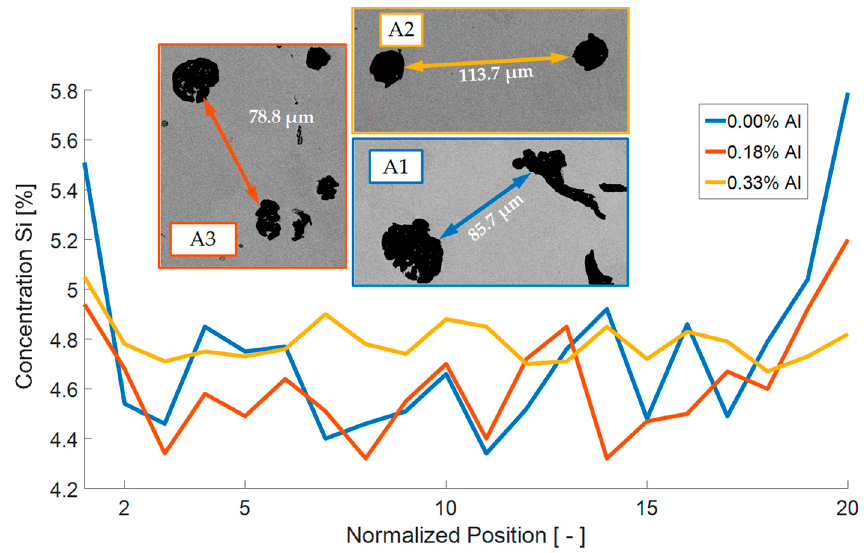
Figure 3. Normalized EDS line scan to determine local silicon concentration for alloys A1–A3.